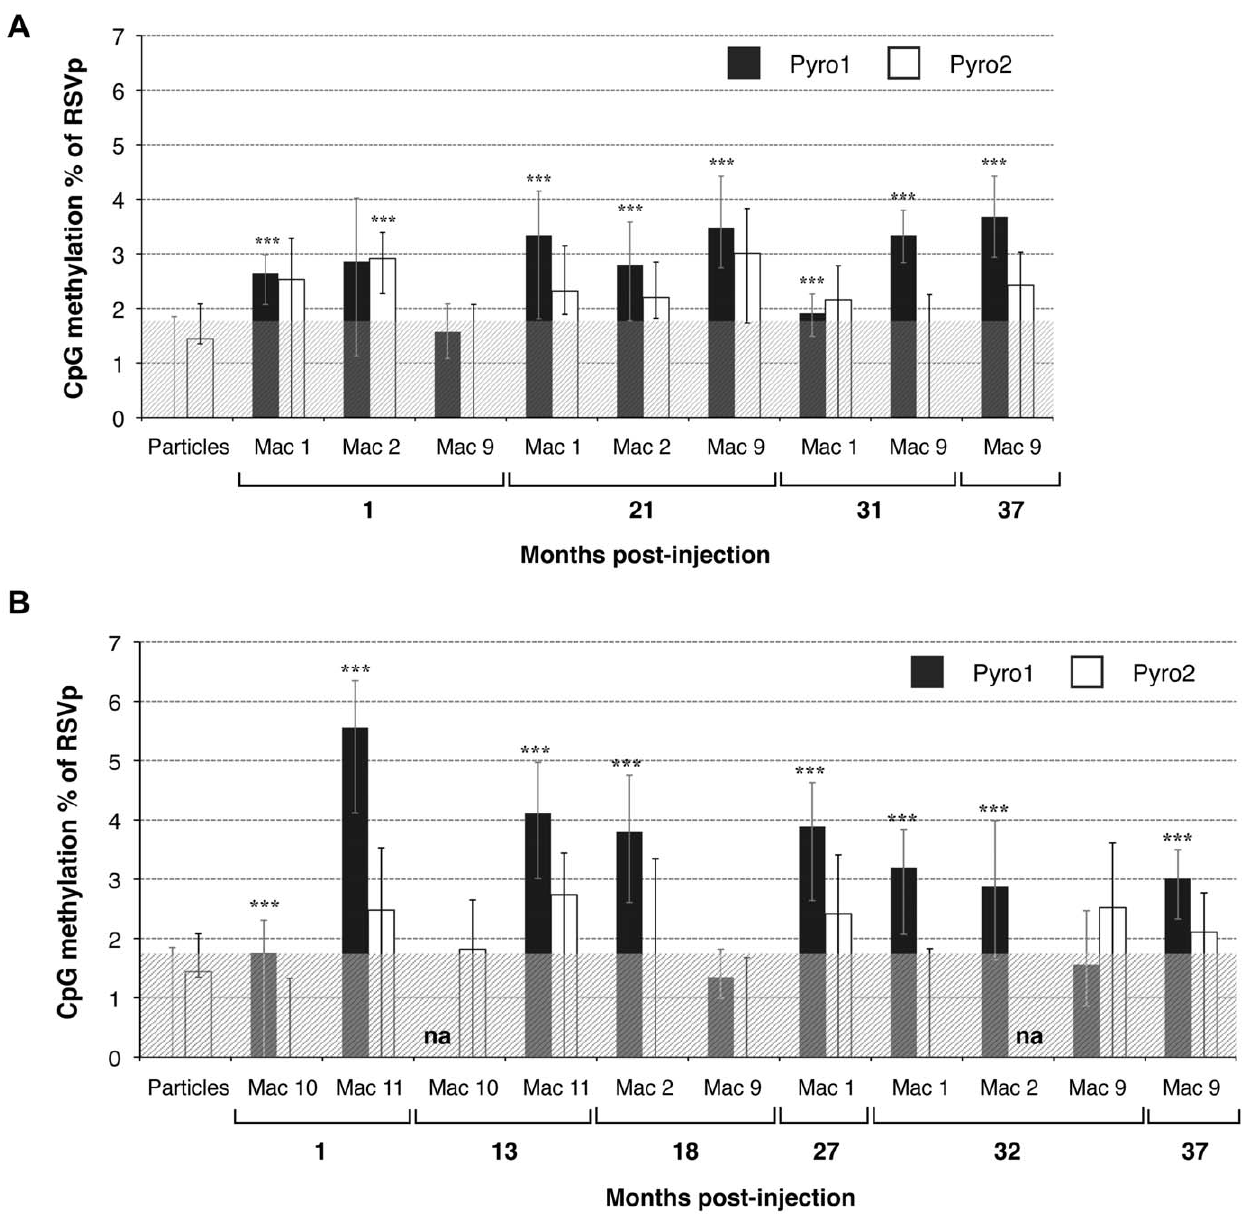
Figure 3. CpG methylation percentage of the RSVp after rAAV administration in NHP determined by low-throughput sequencing. NHP were injected IM (Mac 1, Mac 2, and Mac 9) or IV (Mac 10 and Mac 11) with the rAAV2/1-RSV-LEA29Y-WPRE-pA vector. Each animal received a dose of 5.10 12 vg/kg. Total DNA was extracted from transduced skeletal muscle (A) and liver (B) and subjected to sodium bisulfite conversion and subsequent PCR amplification. Each sample was read at least 4 times by PSQ96 pyrosequencing for the two CpG-rich plots Pyro1 and Pyro2. na: not analyzable. ( *** ) p value , 0.001.